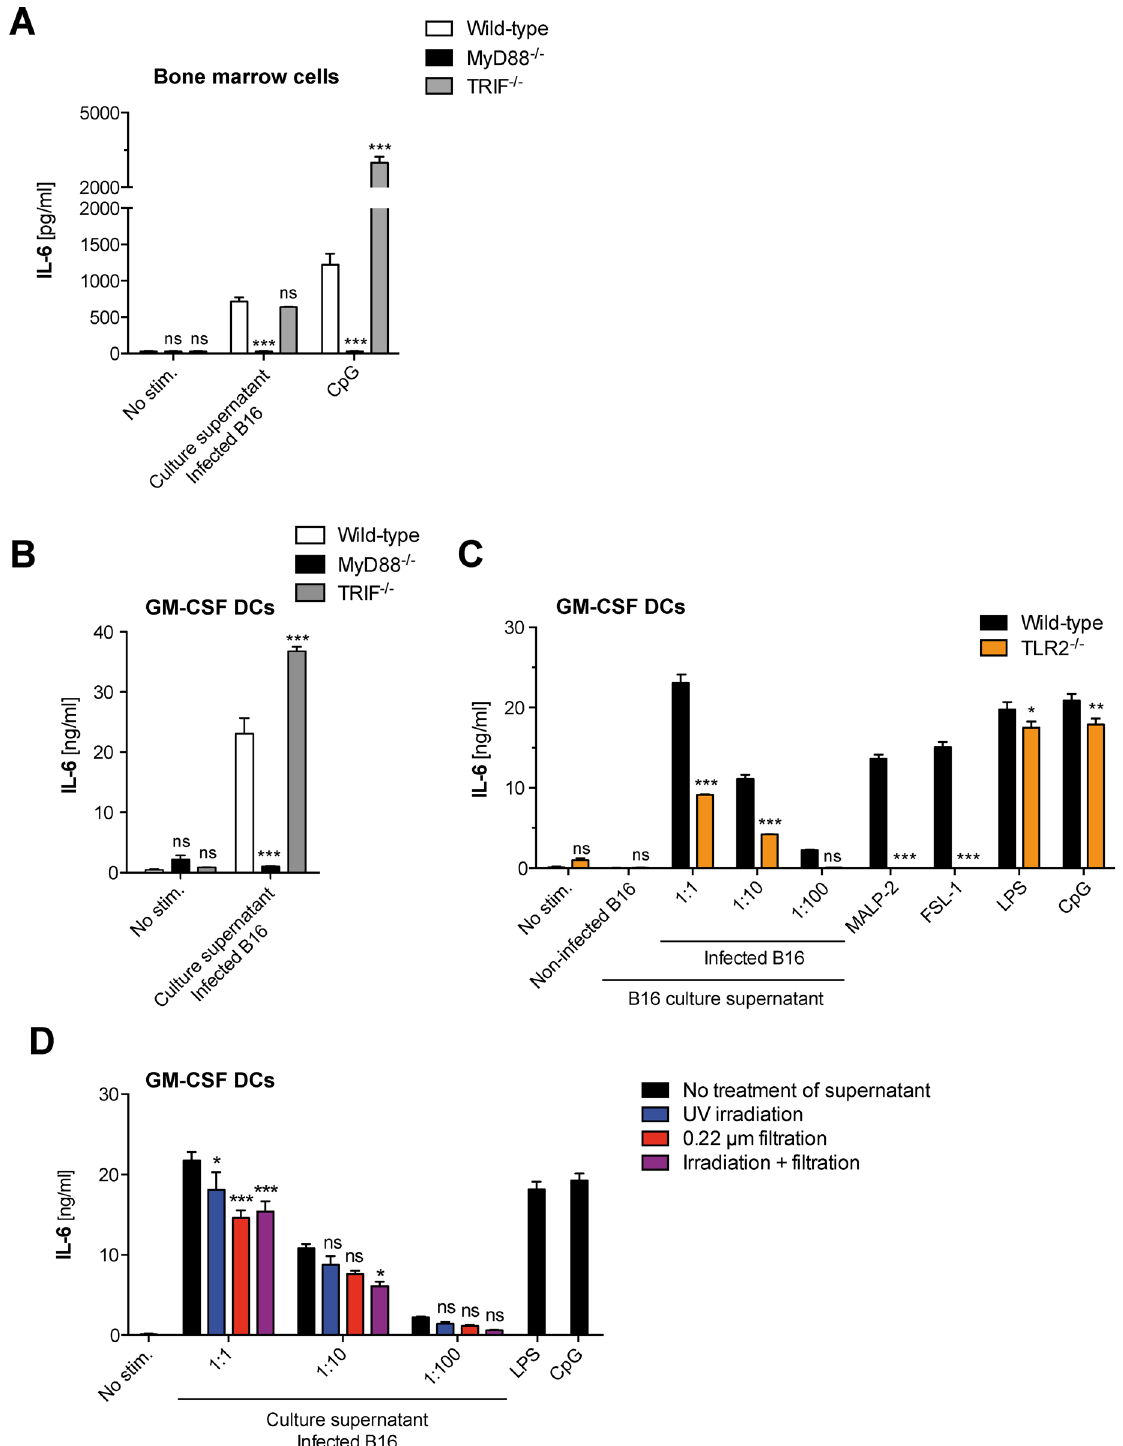
Fig 2. Innate immune activation by Mycoplasma hyorhinis -infected B16 cells is fully dependent on MyD88 signaling but only partially on TLR2. (A) Bone marrow cells or (B) differentiated GM-CSF DCs from wild-type, MyD88- or TRIF-deficient mice were cultured in the presence of diluted supernatant from Mycoplasma hyorhinis -infected B16 cells for 18 h. IL-6 levels in the immune cell culture supernatant were analyzed by ELISA. (C) GM-CSF DCs from wild-type and TLR2-deficient mice were cultured as in (A) in the presence of diluted supernatant from Mycoplasma hyorhinis -infected B16 cells and IL-6 levels in the DC culture supernatant were analyzed by ELISA. (D) GM-CSF DCs from wild-type mice were cultured as in (A). In some conditions, the diluted